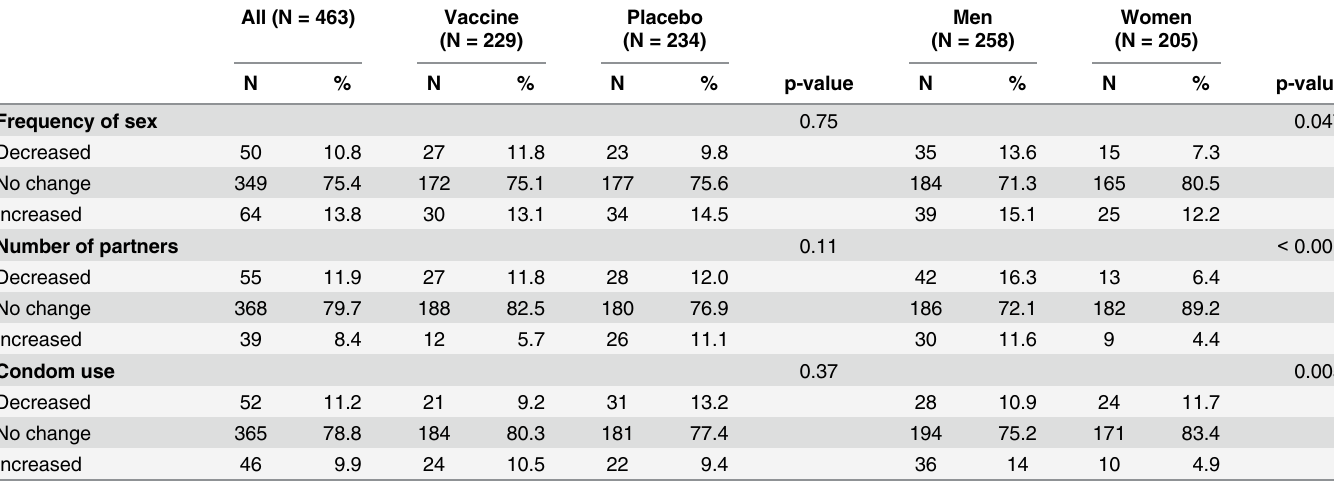
Table 5. Change in self-reported risk behavior between one year before and one year after last Phambili